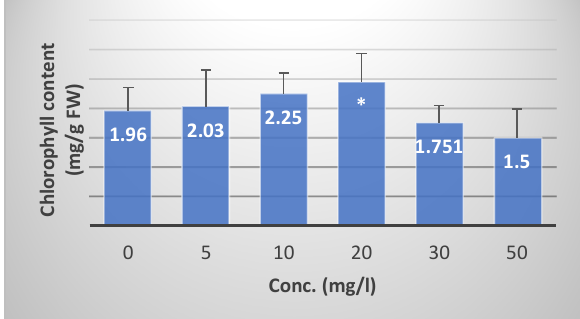
Figure 5. Chlorophyll content of C. cajan leaves treated with different SA concentrations * means significant